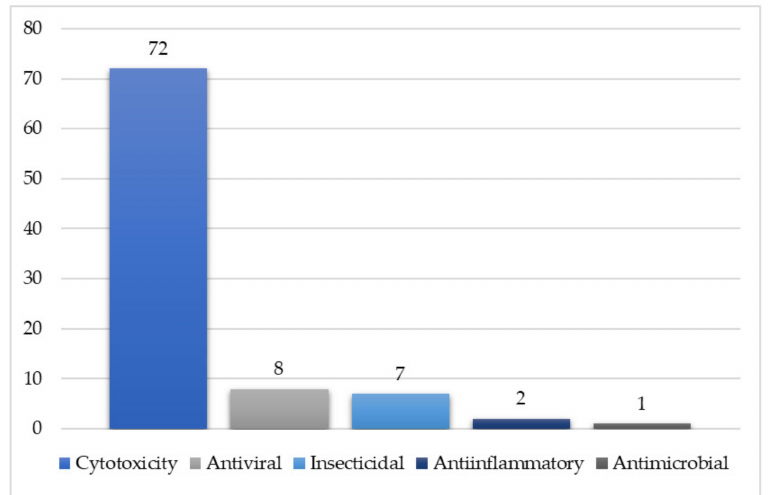
Figure 2. Tested metabolites for each biological